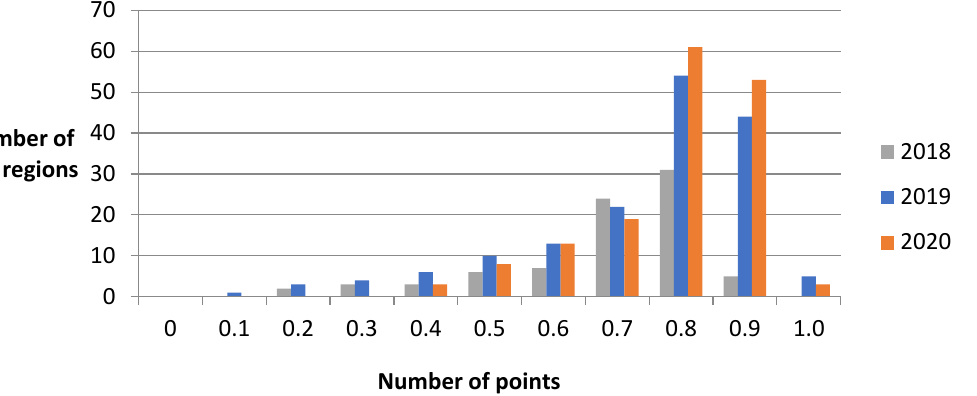
Figure 2. The share of PwD (their legal representatives) who are satisfied with the quality of the AT provision.